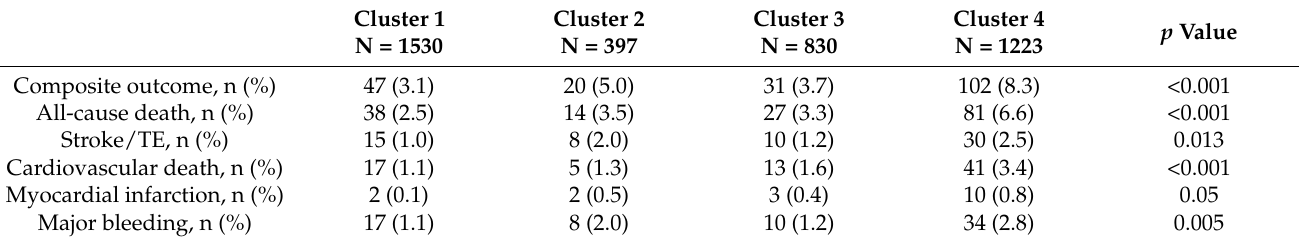
Table 2. Major adverse events stratified by